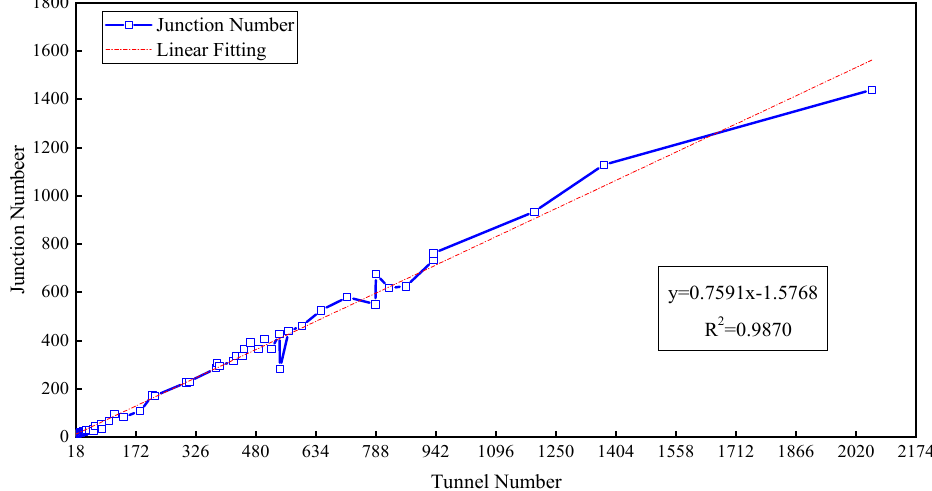
Figure 2. Correlation between the junction number and tunnel number.